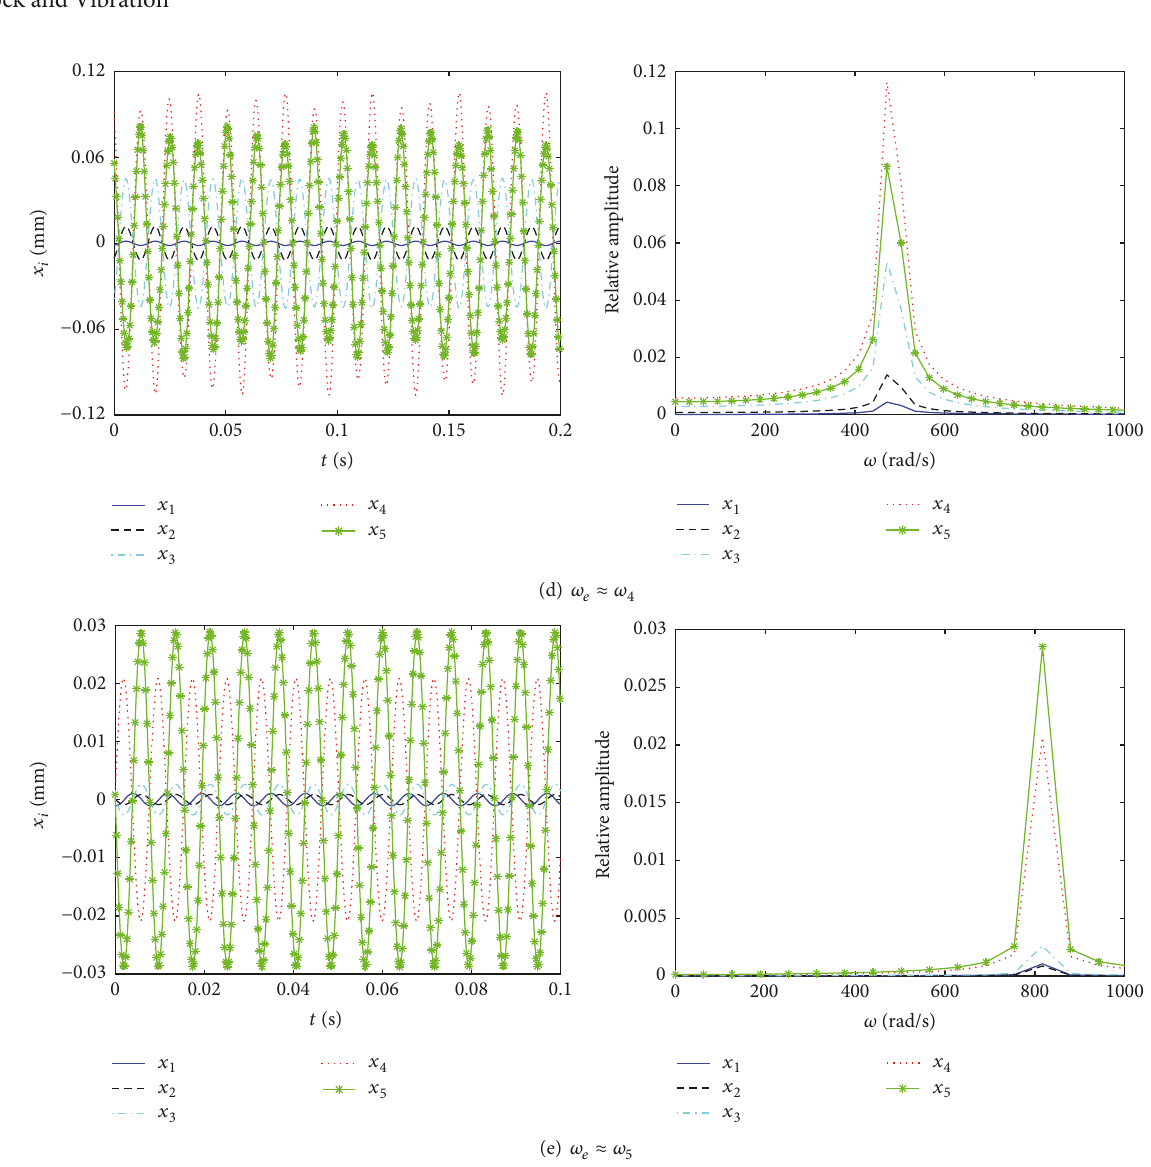
Figure 6: Main resonance when 𝜔 𝑒 ≈ 𝜔 𝑖